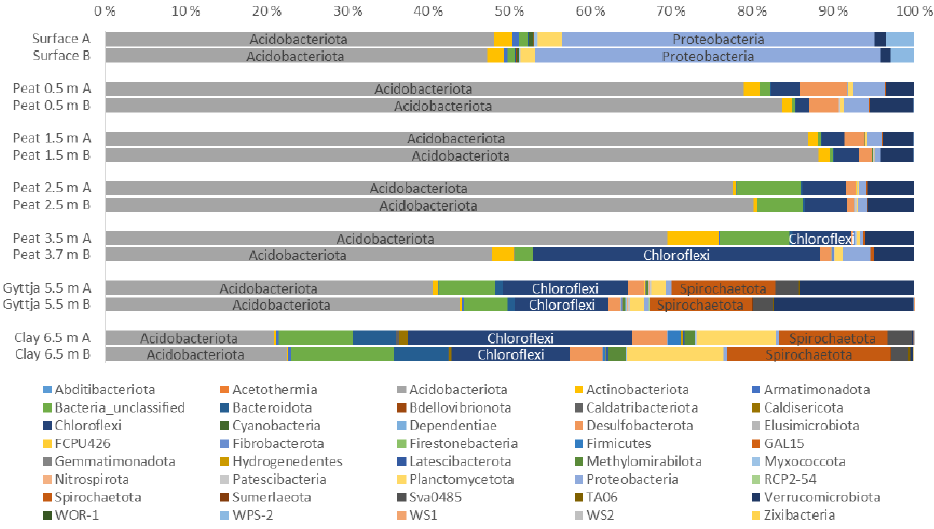
Figure 5. Relative distribution of bacterial phyla in surface moss, peat, gyttja, and clay samples collected from Lastensuo Bog. Each depth is represented by duplicate samples A and B.